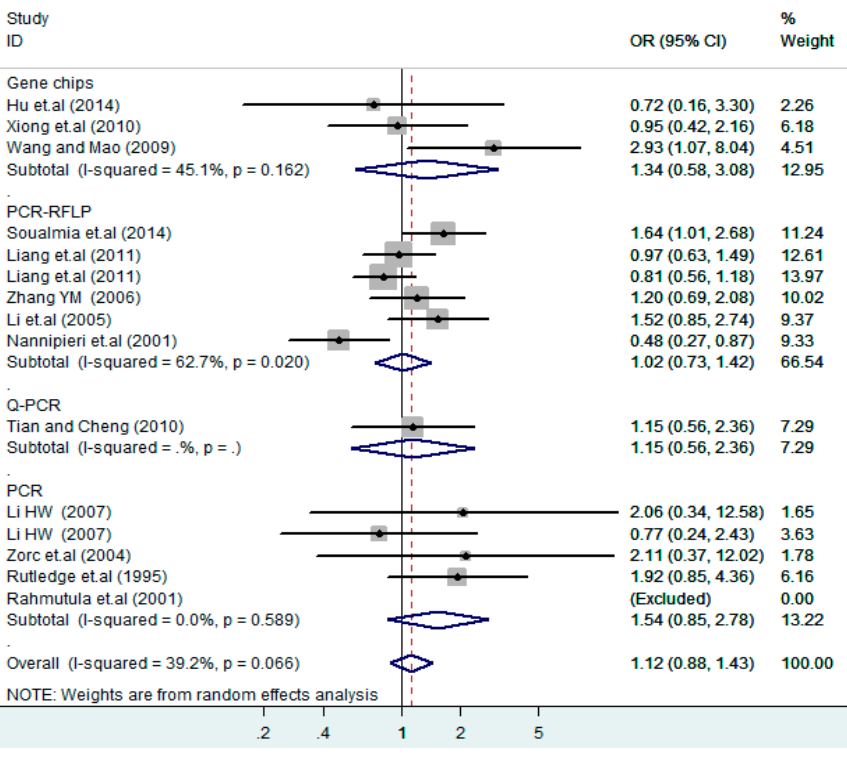
Figure 22. Subgroups of genotyping methods of T2238C dominant model (CC + TC) vs. TT.